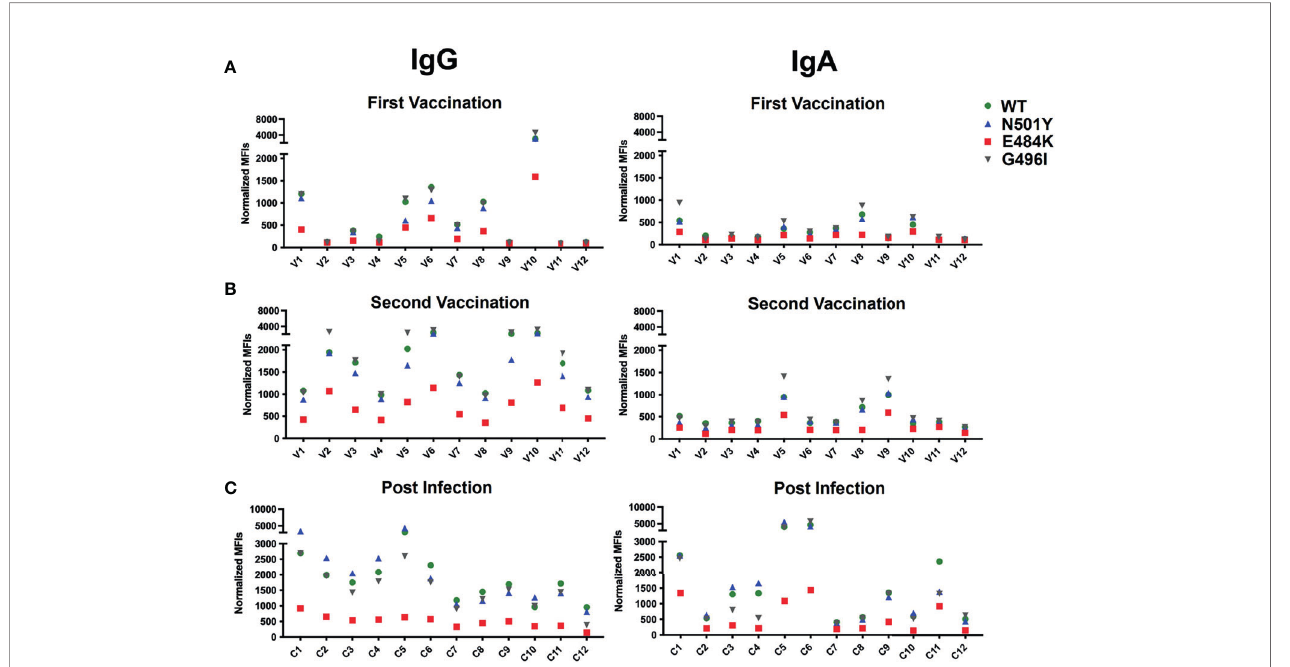
FIGURE 7 | RBD binding activity of the sera of 12 persons vaccinated with the BioNTech/P fi zer mRNA vaccine after the primary (A) and secondary (B) vaccination doses and of 12 patients with severe COVID-19 disease (C) . Shown is the IgG (left panel) and IgA (right panel) antibody response of the sera diluted 1:100 and analyzed for binding to Ramos cells expressing RBD-CD8 protein with either a WT (green), or an N501Y (blue), E484K (red) or G496I (grey) mutated RBD sequence. Shown are normalized MFI